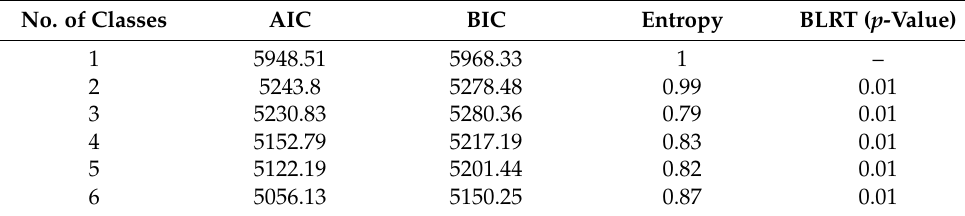
Table 2. Summary of information for selecting the number of latent classes for latent profile analysis. No. of Classes AIC BIC Entropy BLRT ( p -Value) 1 5948.51 5968.33